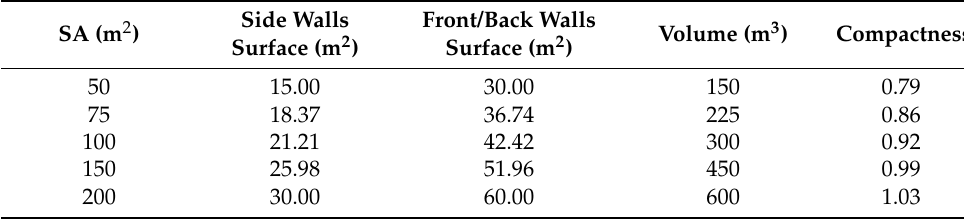
Table 6. Compactness of buildings with different SA values and AR equal to 2.